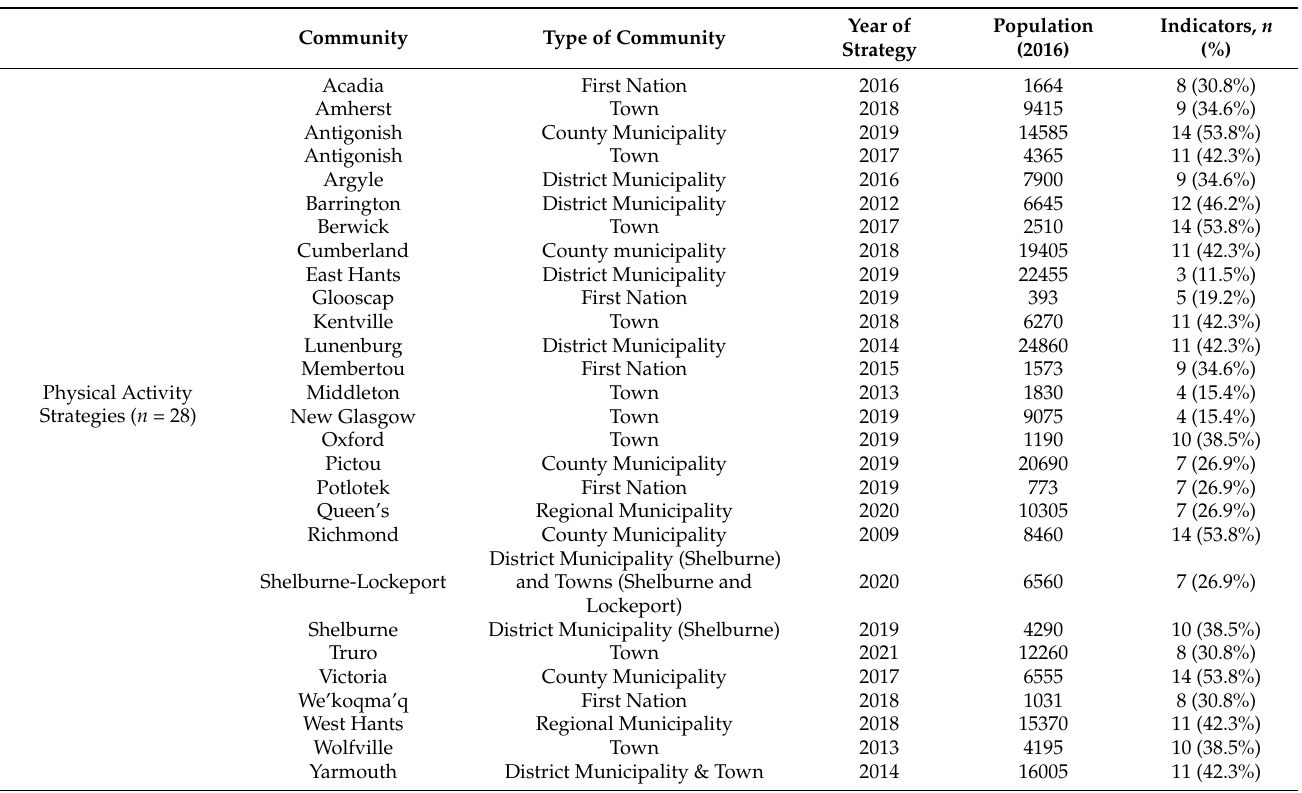
Table 2. Communities, year of strategy, population, and frequency and prevalence of indicators included per physical activity or active transportation